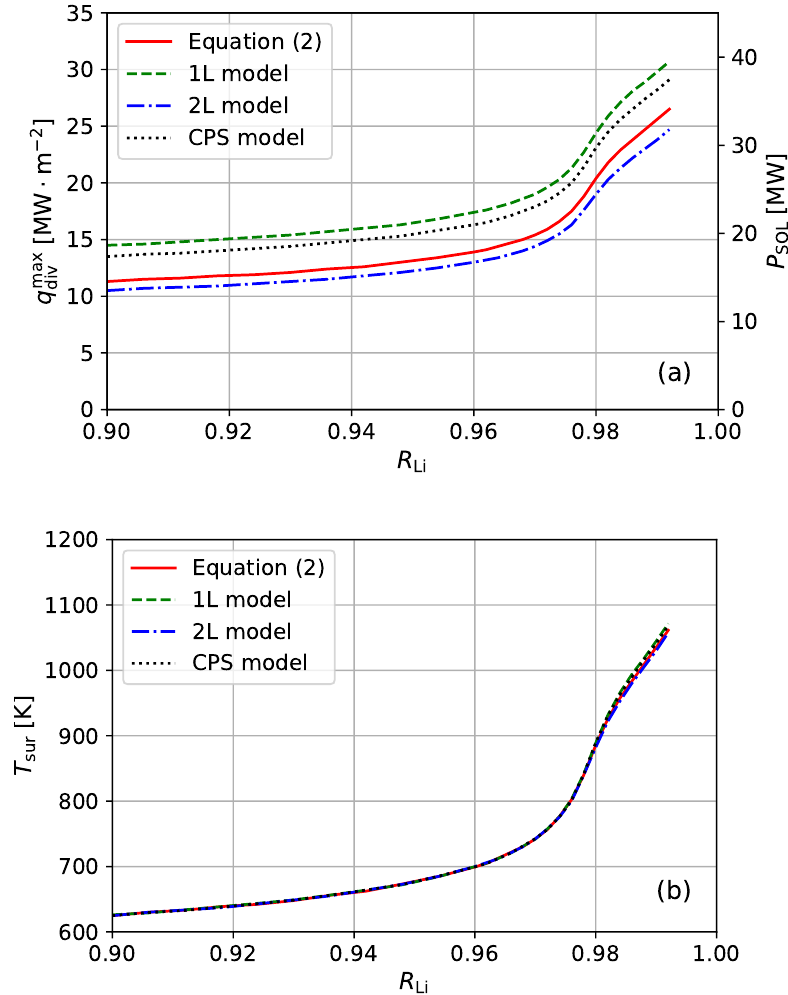
Figure 7. The maximum tolerable heat load q max ( a ) and the target surface temperature T sur ( b ) as div functions of lithium prompt the redeposition factor R Li . The notations are identical to Figure